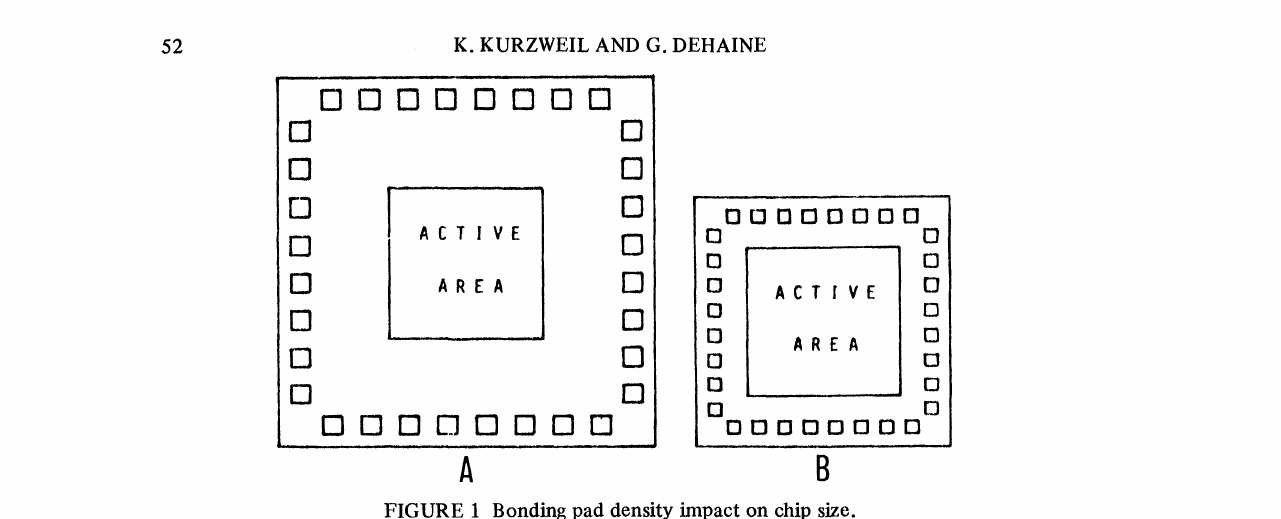
FIGURE Bonding pad density impact on chip size.